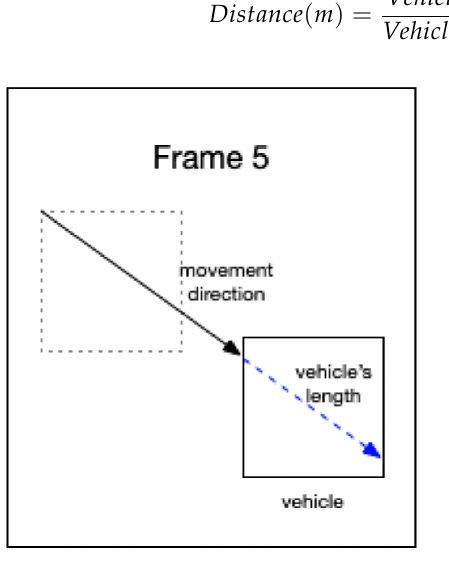
Figure 9. The vehicle speed